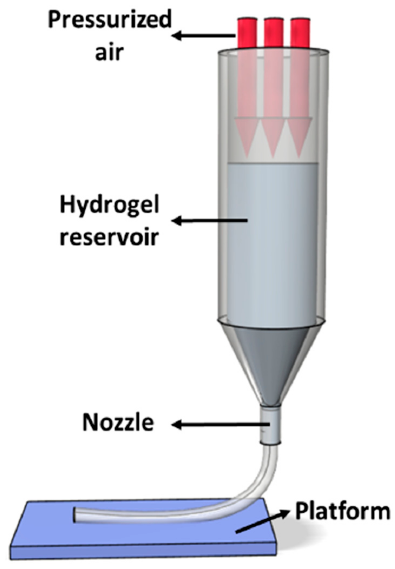
Figure 2. Schematic of pneumatic extrusion.